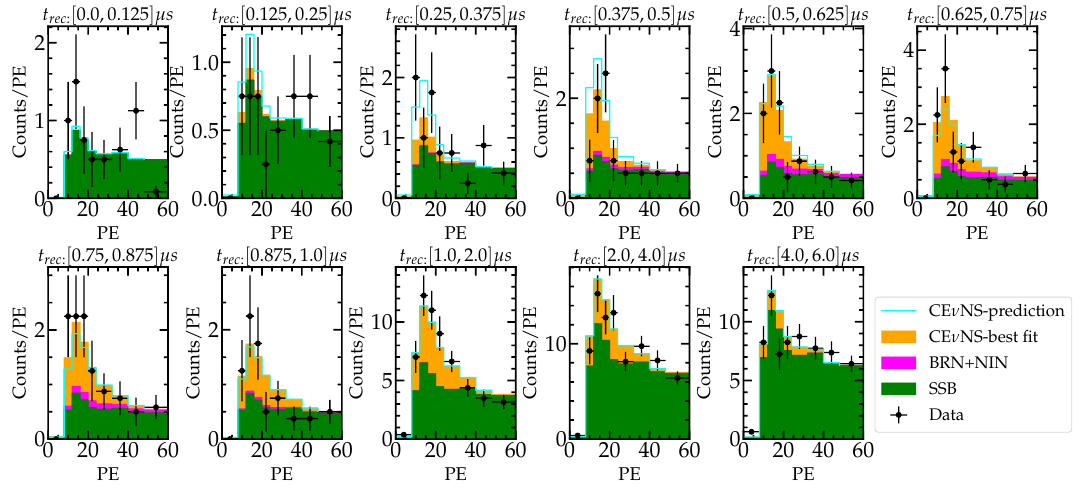
Figure 18 . Simulation of the event spectra at COHERENT-CsI along with the experimental data of COHERENT-CsI measurement [8] (in agreement with